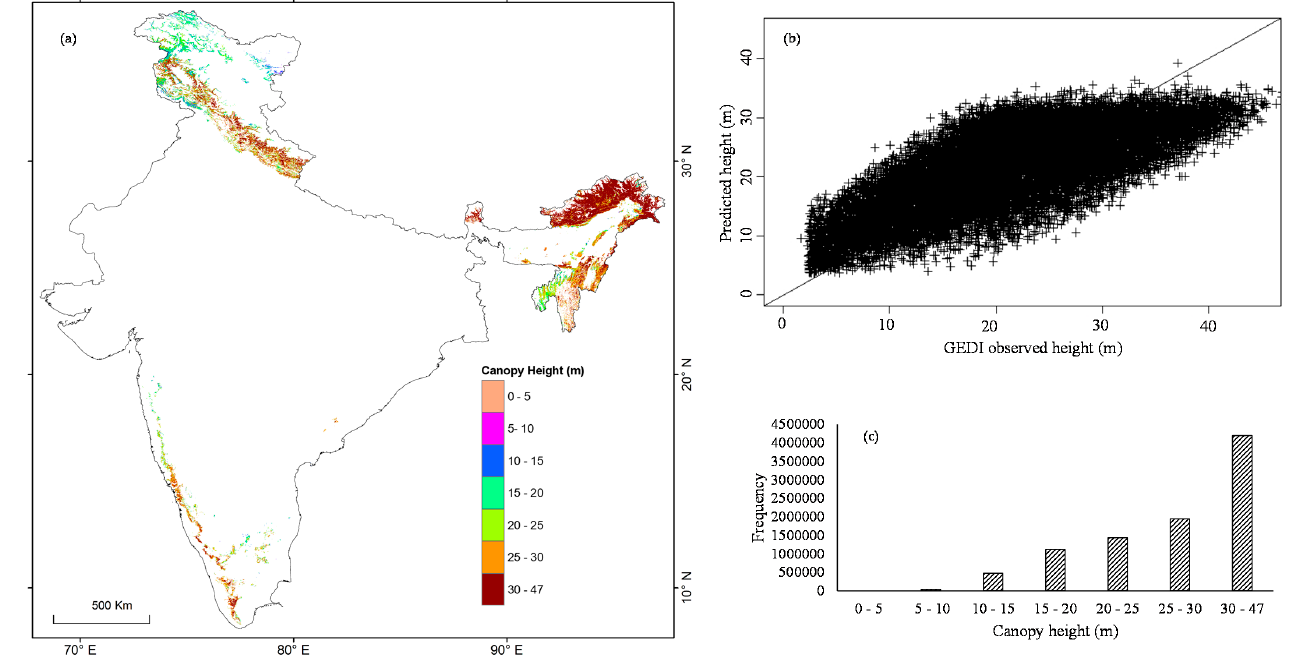
Figure 3. ( a ) GEDI predicted forest canopy height map, ( b ) the RF model predicted vs. the field- estimated height plot using the GEDI data and ( c ) histograms showing the canopy height distribution for the evergreen forests.